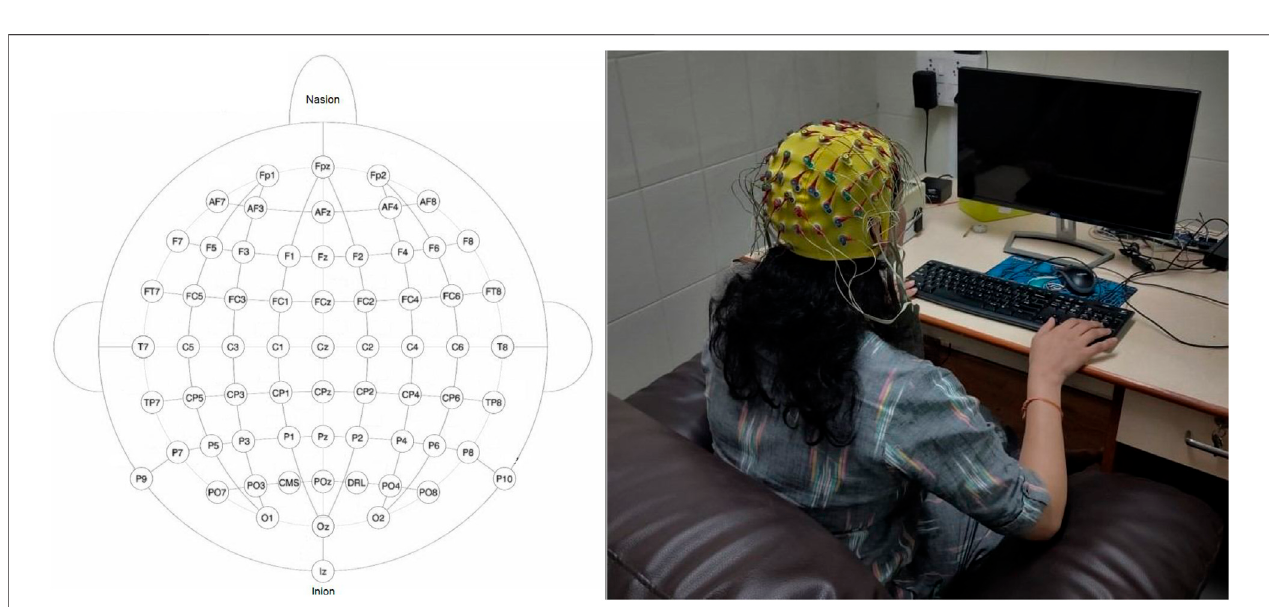
FIGURE 2 | Electrode placement over the scalp and experimental setup. The subject is looking at a monitor from a two-feet distance. The monitor displayed the word and task to be performed. In this illustrative fi gure, the subject was imagining the pronunciation after the word ’ s display. The monitor was blank during imagined speech task.